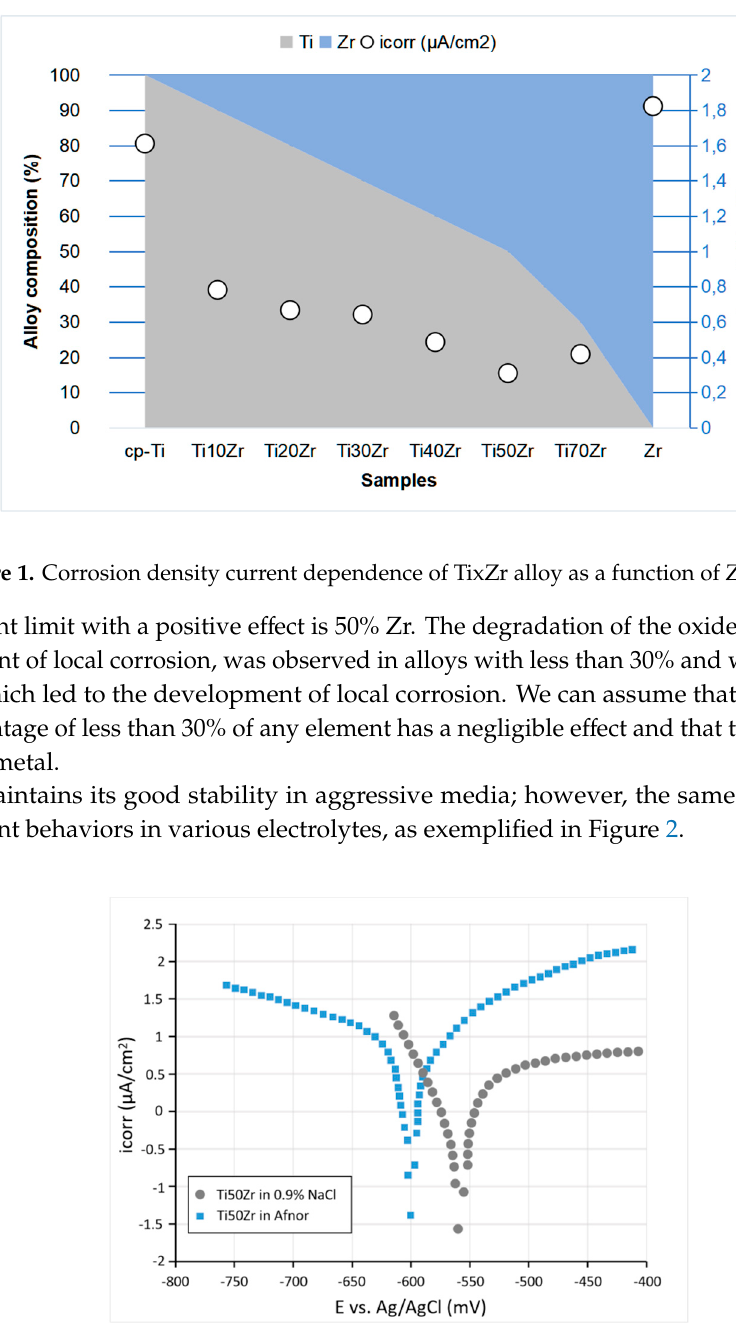
Figure 2. Tafel plots for Ti50Zr resulting from measurements in NaCl 0.9% and Afnor artificial solution.